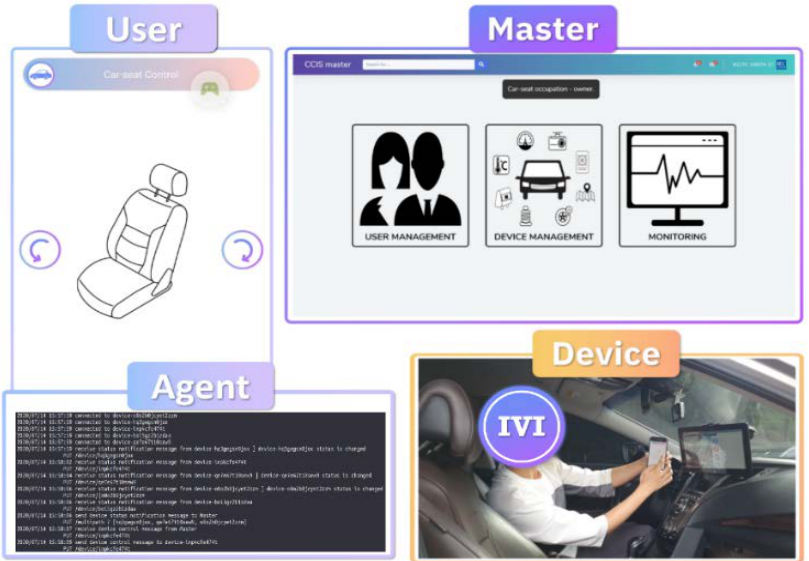
Figure 17. Implementation of IVI system entities.